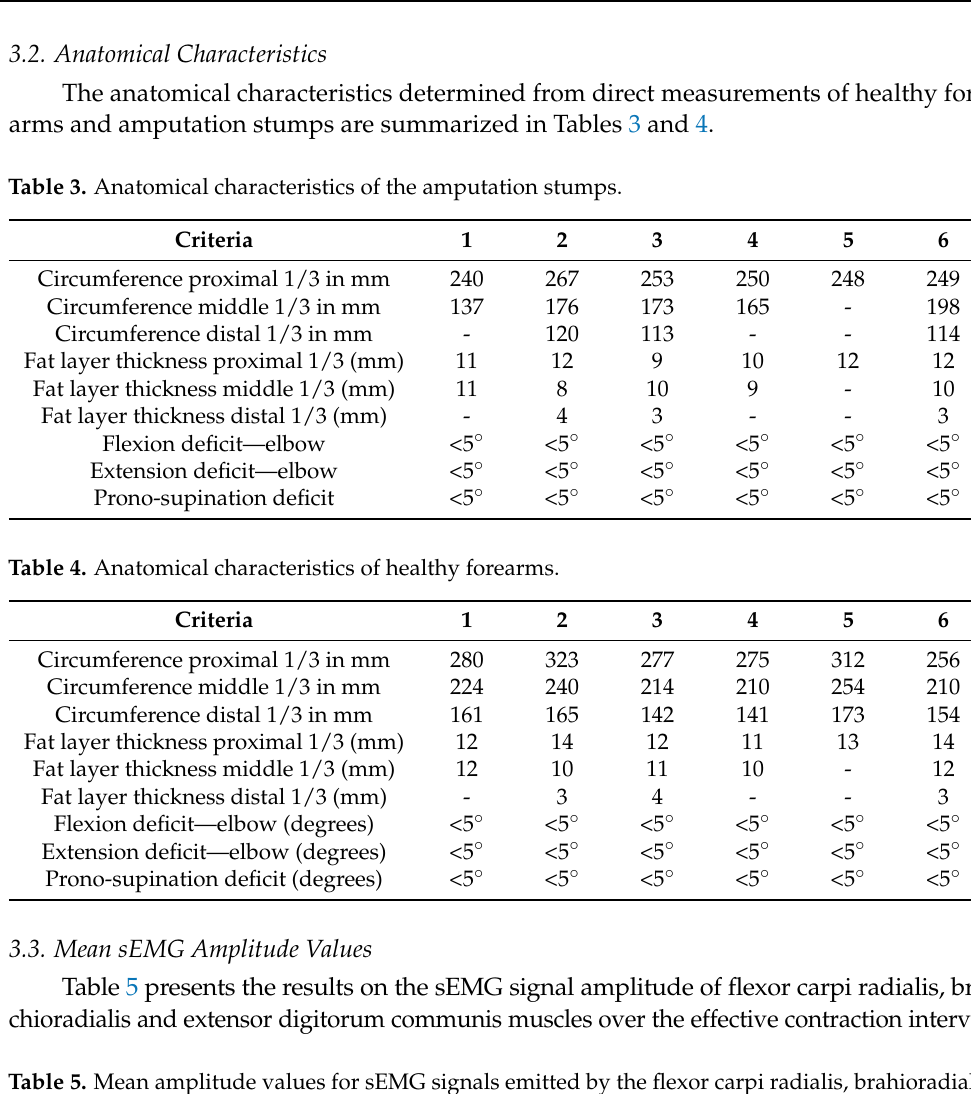
Table 5. Mean amplitude values for sEMG signals emitted by the flexor carpi radialis, brahioradialis and extensor digitorum communis